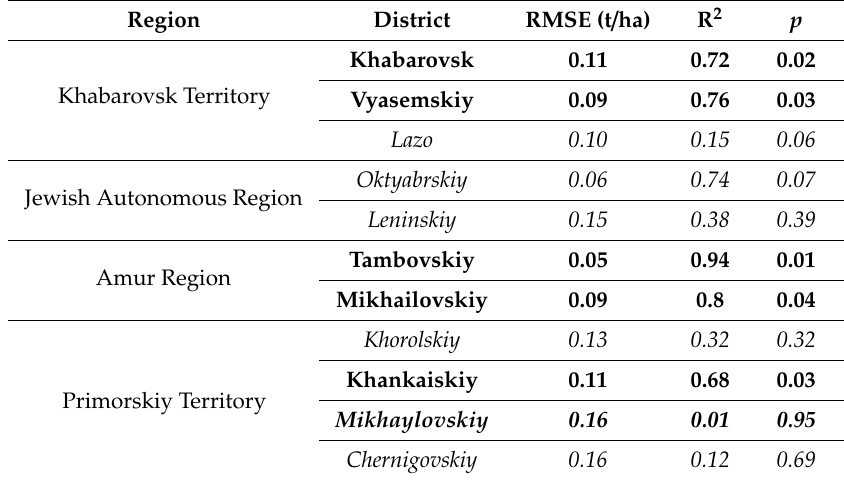
Table 11. Average RMSE results for the di ff erent municipalities in the Russian Far East (2010–2018). Significant results highlighted bold, insignificant highlighted